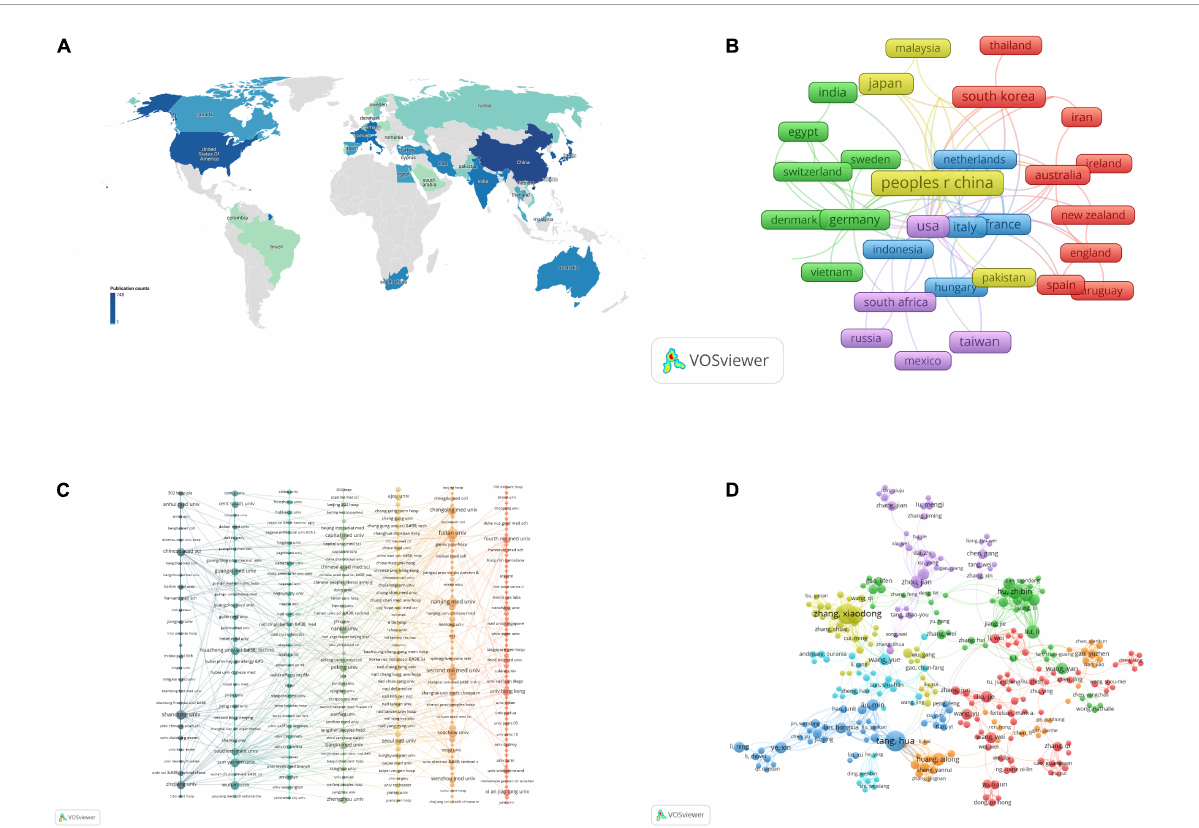
FIGURE3 The co-authorship analysis of non-coding RNA and hepatitis B virus (HBV)-related hepatocellular carcinoma. (A) Distribution of country/region. (B) The co-authorship network of country/region. (C) The co-authorship network of the institution. (D) The co-authorship network of authors. Each node represents a country/region (A,B) , institution (C) , and author (D) , respectively. The size of nodes represents the publication number. The connection between nodes represents collaboration. The distance and thickness of the connection represent the relative strength of the relationship.